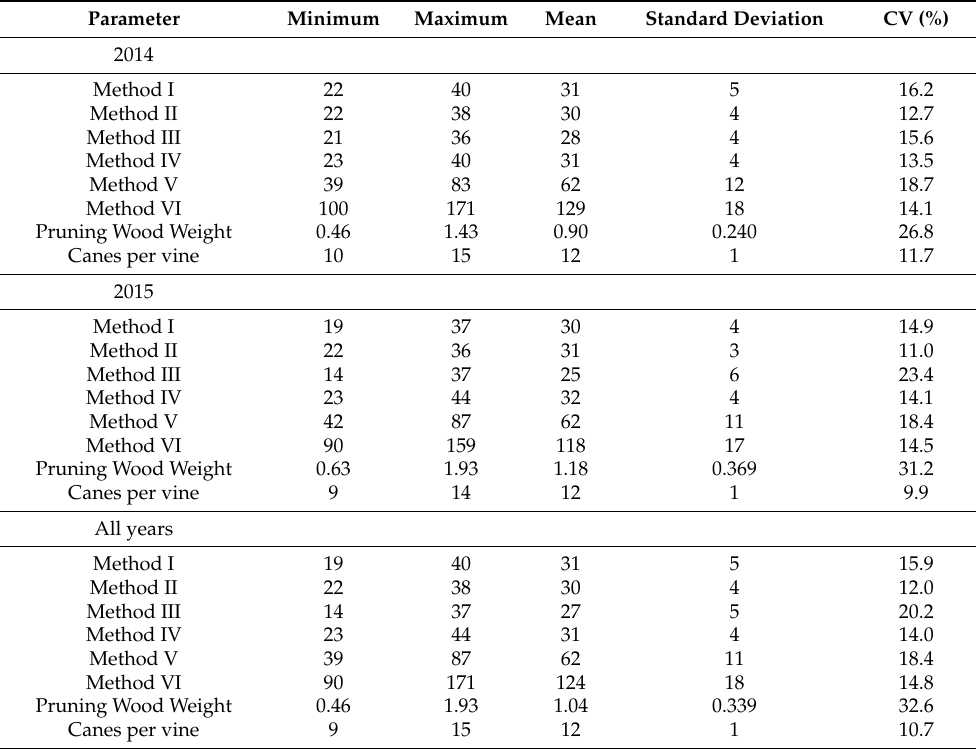
Table 2. Descriptive statistics of measurements of the Sauvignon Blanc